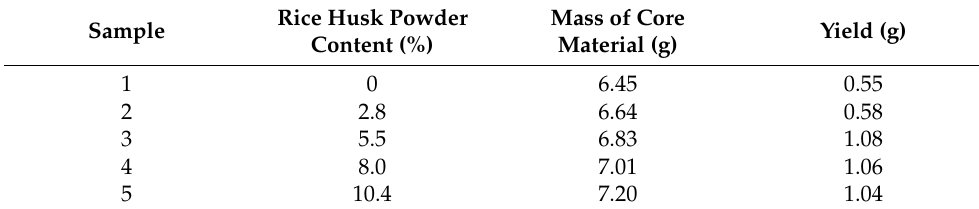
Table 7. Yield of microcapsules in the single-factor test.